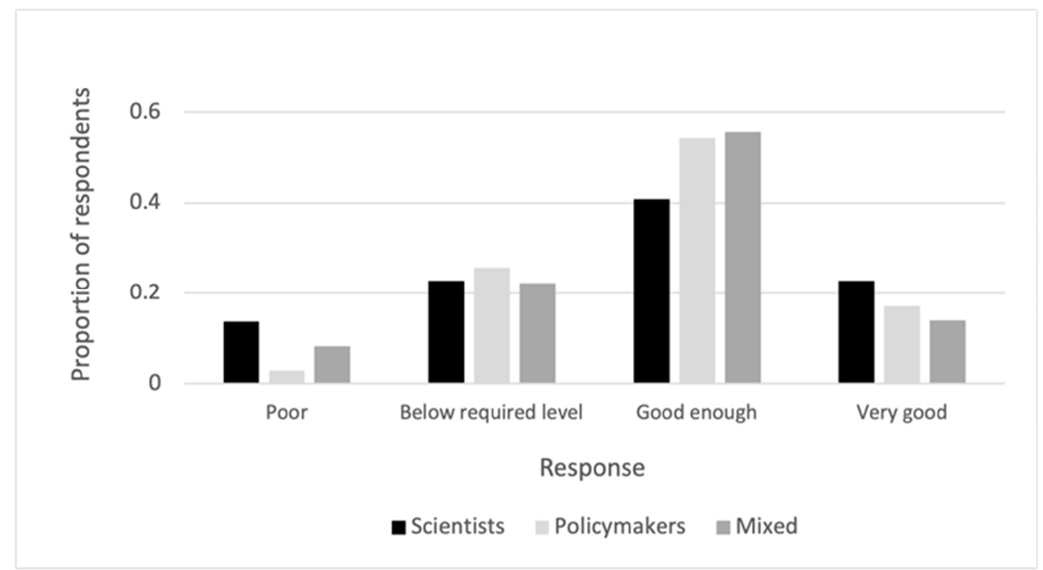
Figure 3. Distribution of responses given by scientists, policymakers, and mixed respondents to the question, “how well is (the best available) mechanism bridging the gap compared with the best science-policy communication about 10 years ago?”.